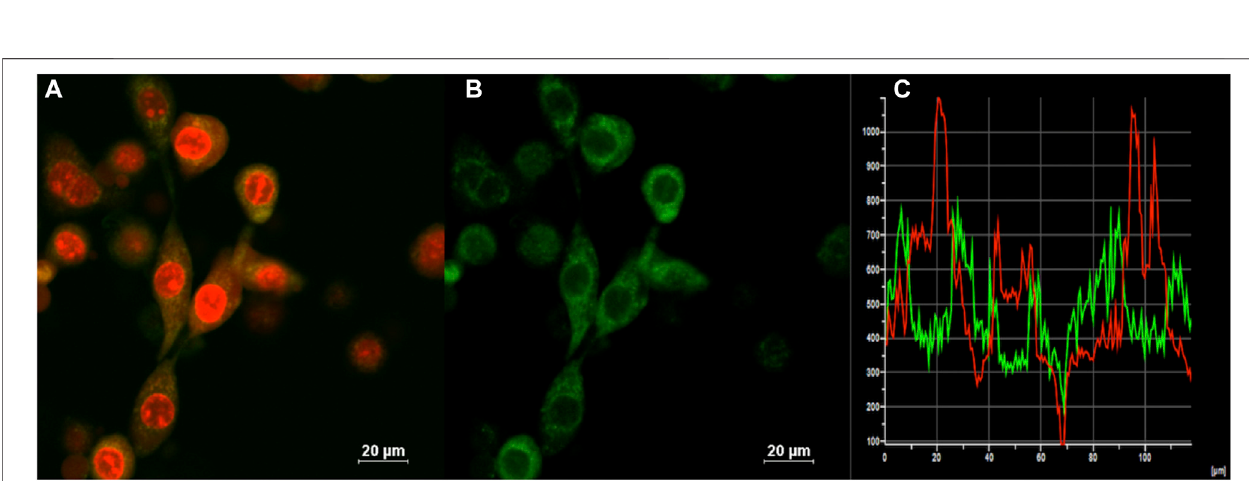
Frontiers in Chemistry |